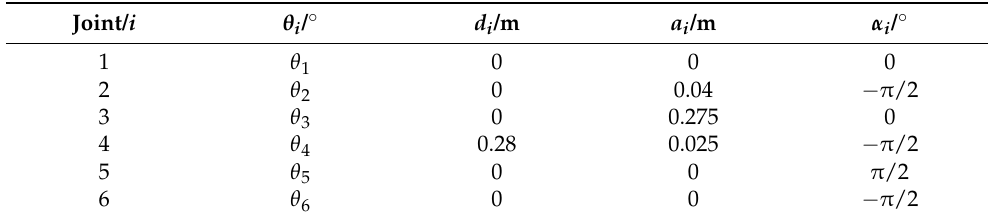
Figure 8. Schematic diagram of the robot connecting rod structure. Table 1. D-H